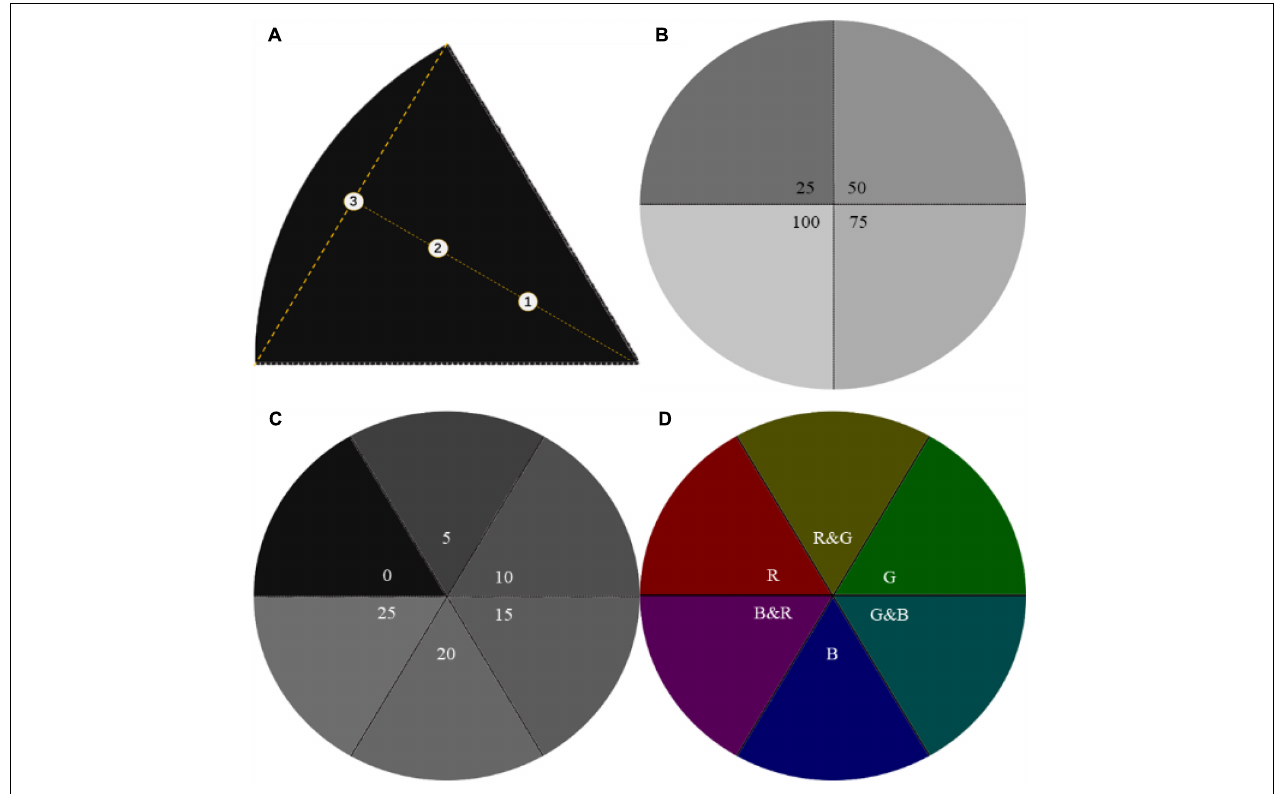
FIGURE 2 | Sampling points and light source images. (A) The markers (cid:192)(cid:193)(cid:194) are the sampling points on the centerline in a sector, and (cid:192)(cid:193) is the trisection of the vertical. (B) Light intensity of GMTC at 25/50/75/100 lx in the first phase. (C) Light intensity of GMTC at 0/5/10/15/20/25 lx in the second phase. (D) The three primary colors (TPCs) and the geometric mixed secondary colors (GMSCs) at 5 lx in the third phase.